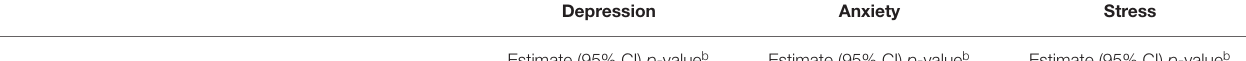
TABLE 2 | Mediated, unmediated, and total effects for compassion cultivating training (CCT) on symptoms of depression, anxiety, and stress (DASS) in caregivers of people with mental illness at the 6-month follow-up in a longitudinal path model design with four repeated measurements in an RCT ( n = 161) a .